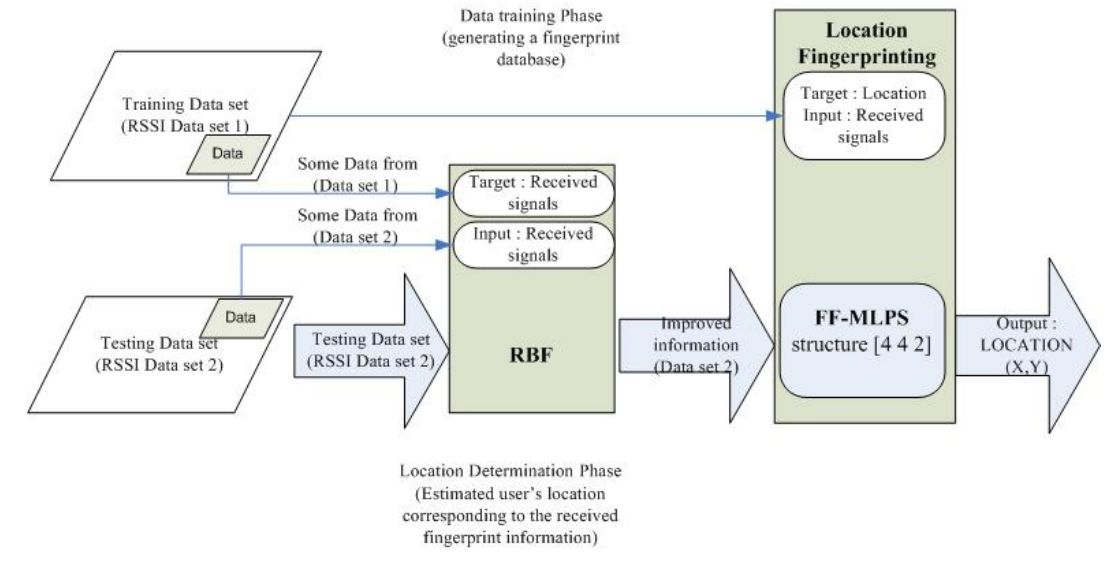
Figure 7. Location Estimate by FF ‐ MLP ANN in combination with radial basis function (RBF).